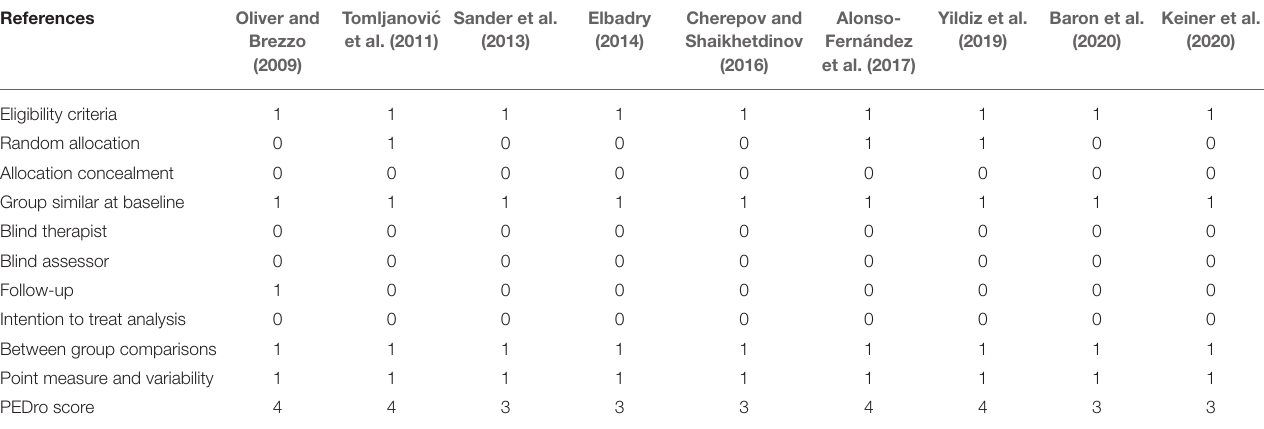
TABLE 3 | Summary of methodological quality assessment